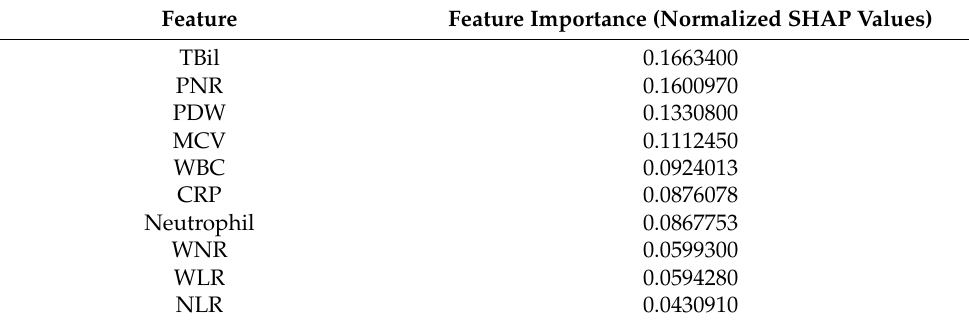
Table 3. Metrics for classification of perforated